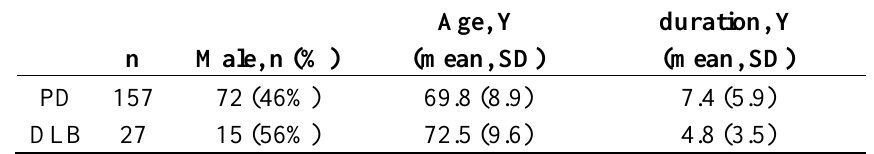
Table 1. Demographic data of study subjects for relationship disease onset age and disease progression.